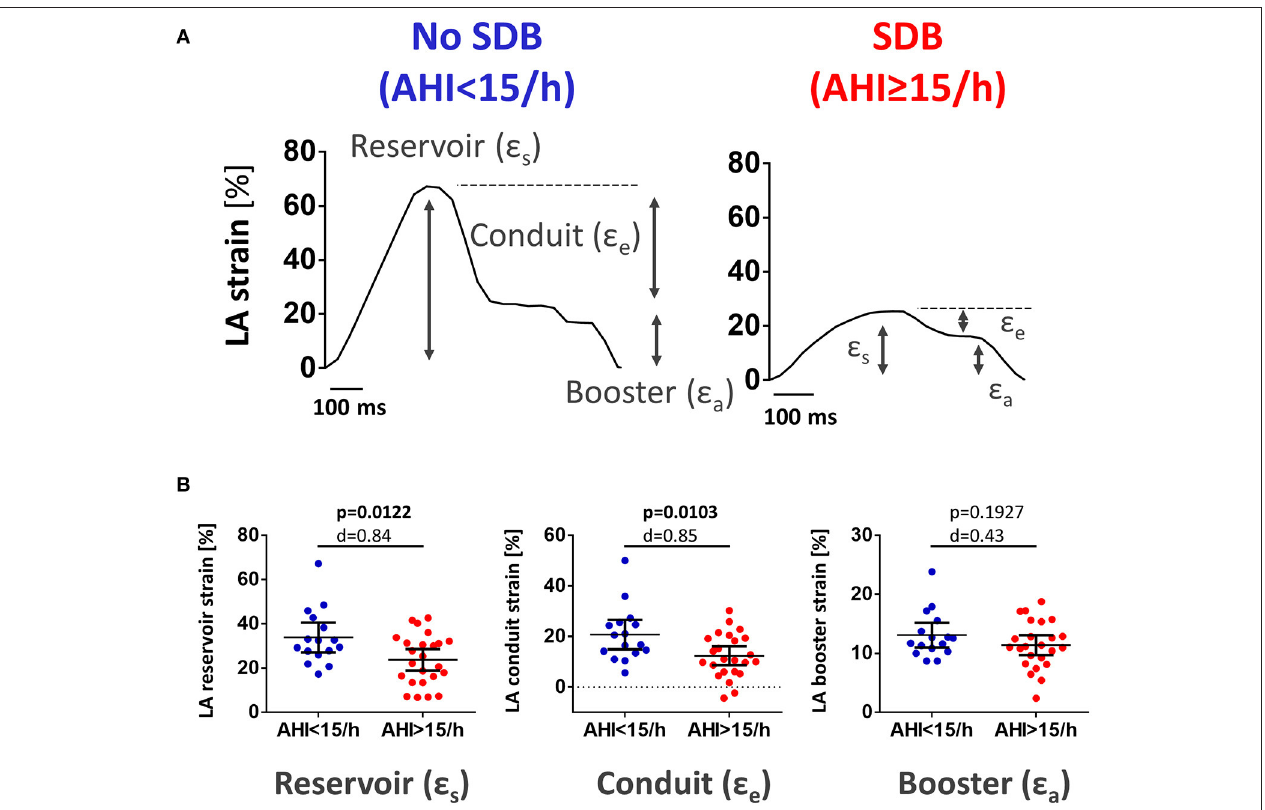
FIGURE 2 | LA reservoir and conduit function were reduced in patients with SDB. (A) Original recording of cardiac magnetic resonance imaging feature tracking tracings of left atrial global longitudinal strain in a patient presenting with acute MI without SDB (left) and with SDB (right). Gray arrows indicate the individual components of LA strain: reservoir ( ε s ), conduit ( ε e ), and booster ( ε a ). (B) Mean data for LA reservoir, conduit, and booster strain as dichotomized scatter plots. In patients with SDB, there was a significant decrease in LA reservoir and conduit strain. LA booster strain was not different between both groups. Dichotomized scatter plots include p -values and Cohen’s